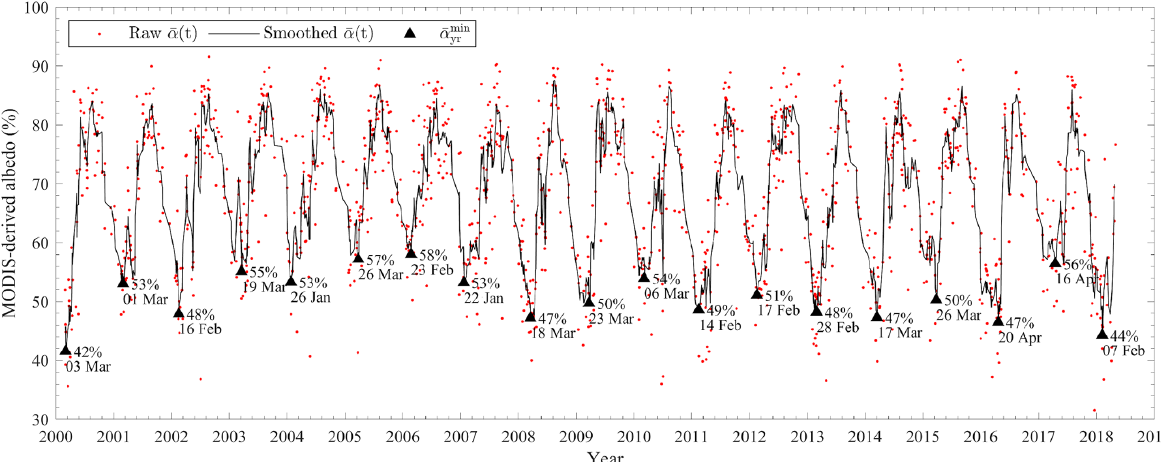
Figure 10. MODIS-derived glacier-wide surface albedo ¯ α(t ) on Vertebrae Col 25 between February 2000 and April 2018, with the three- period rolling average and annual minimum glacier-wide albedo ¯ α min yr indicated in black.